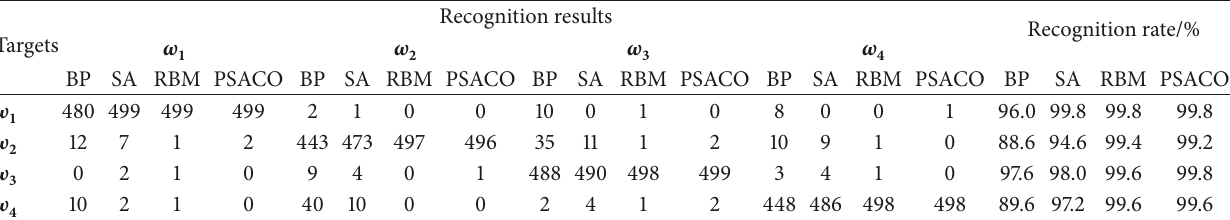
Table 6: Recognition results of CNIS-III for original